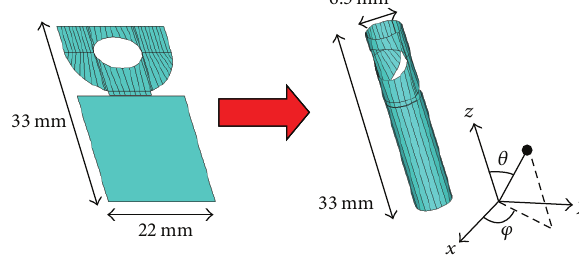
Figure 4: Rolled UWB antenna for